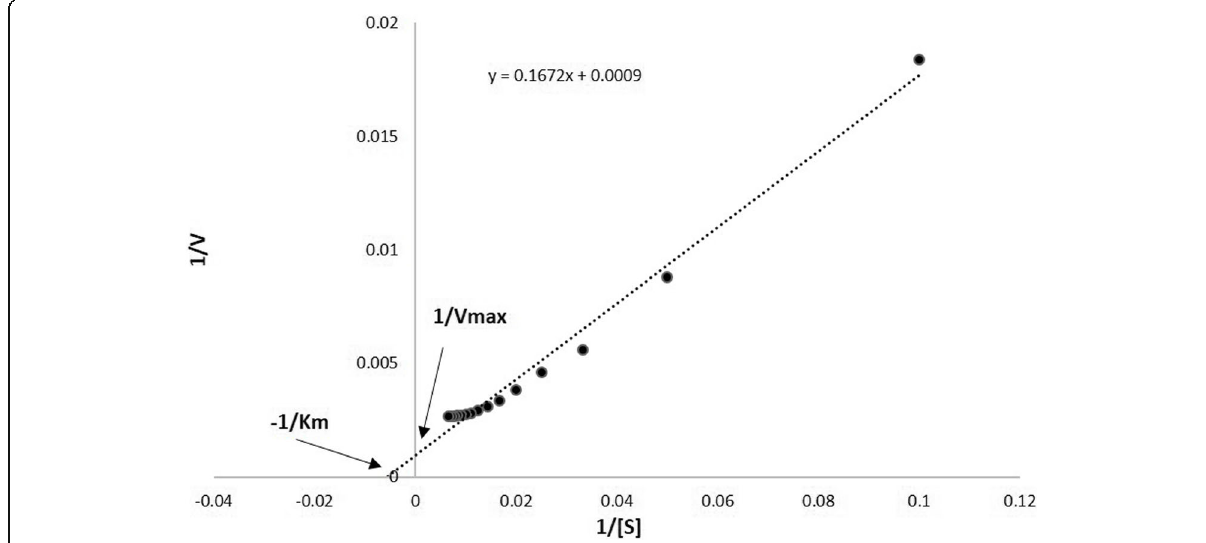
Fig. 4 Lineweaver – Burk plot indicating Michaelis – Menten constant (Km), Maximum velocity (Vmax) and Substrate concentration [S]